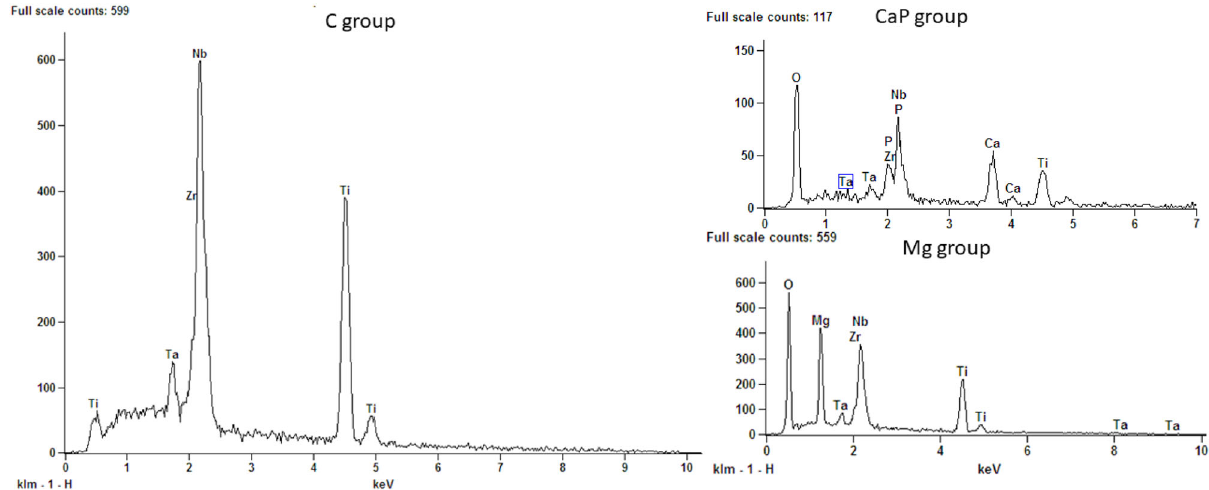
Fig. 3 EDS of study samples